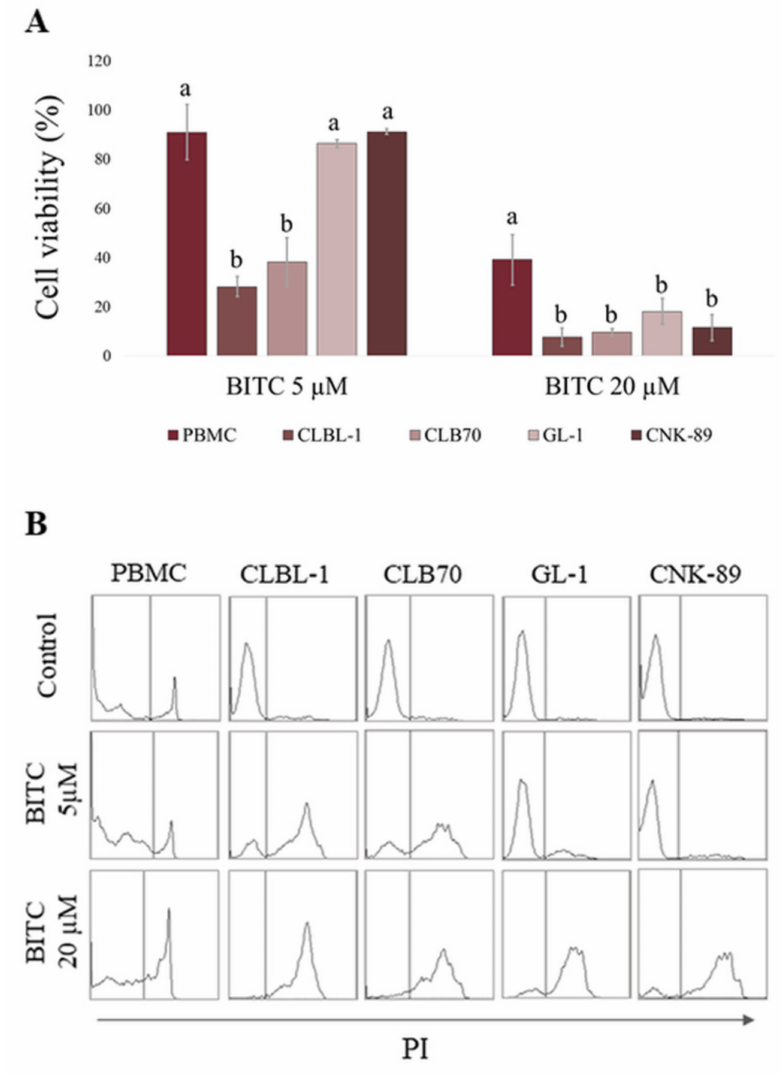
Figure 2. Comparison of BITC activity in canine peripheral blood mononuclear cells (PBMCs) and canine hematopoietic cancer cells (CLBL-1, CLB70, GL-1 and CNK-89) after 24 h incubation with BITC. ( A ) The number of viable cells in BITC treated groups was calculated as a percentage of the viability of untreated control cells. a,b Values with different letters in the superscript differ statistically within the same treatment group ( p < 0.05). ( B ) Representative histograms of cells stained with